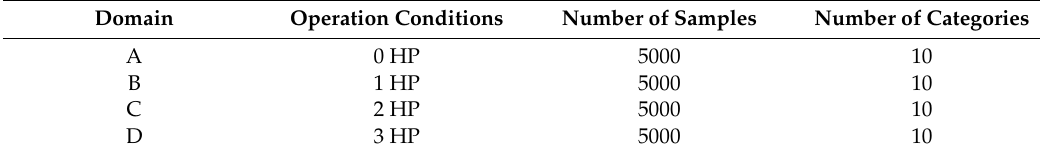
Table 2. Description of dataset.